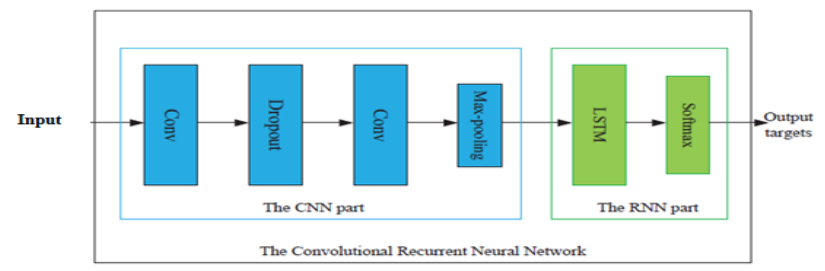
Figure 7. Basic architecture of CRNN.